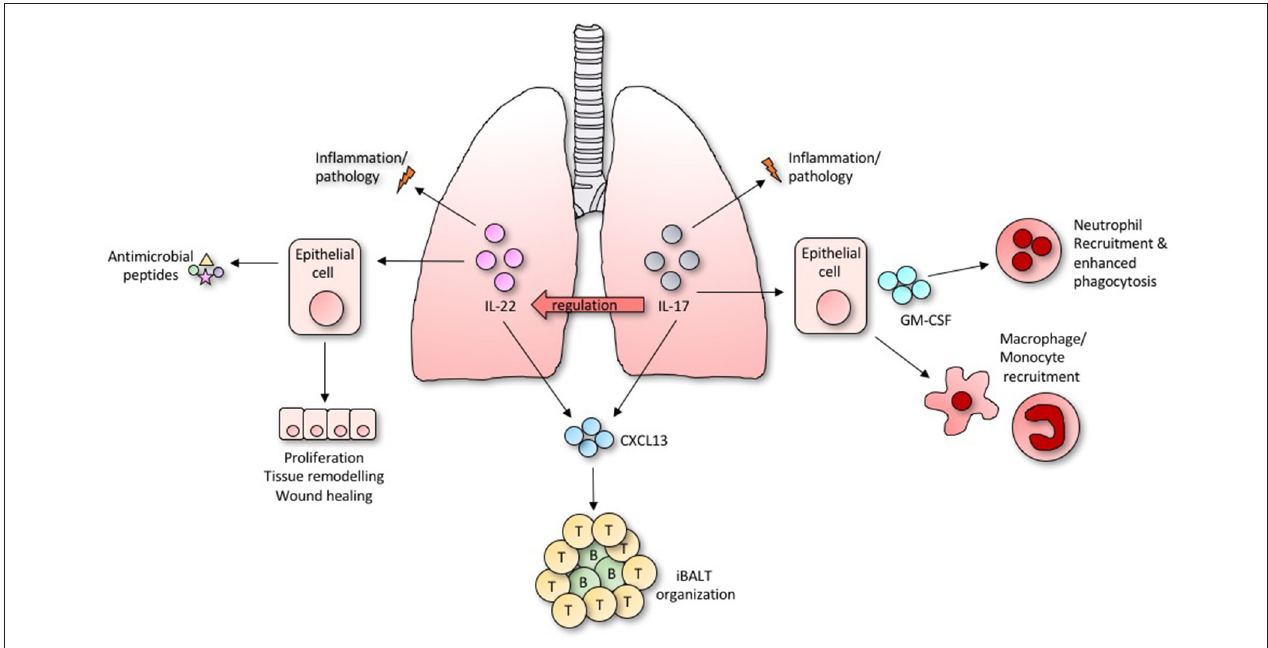
FIGURE 2 | Diverse and overlapping roles of IL-22 and IL-17 within the